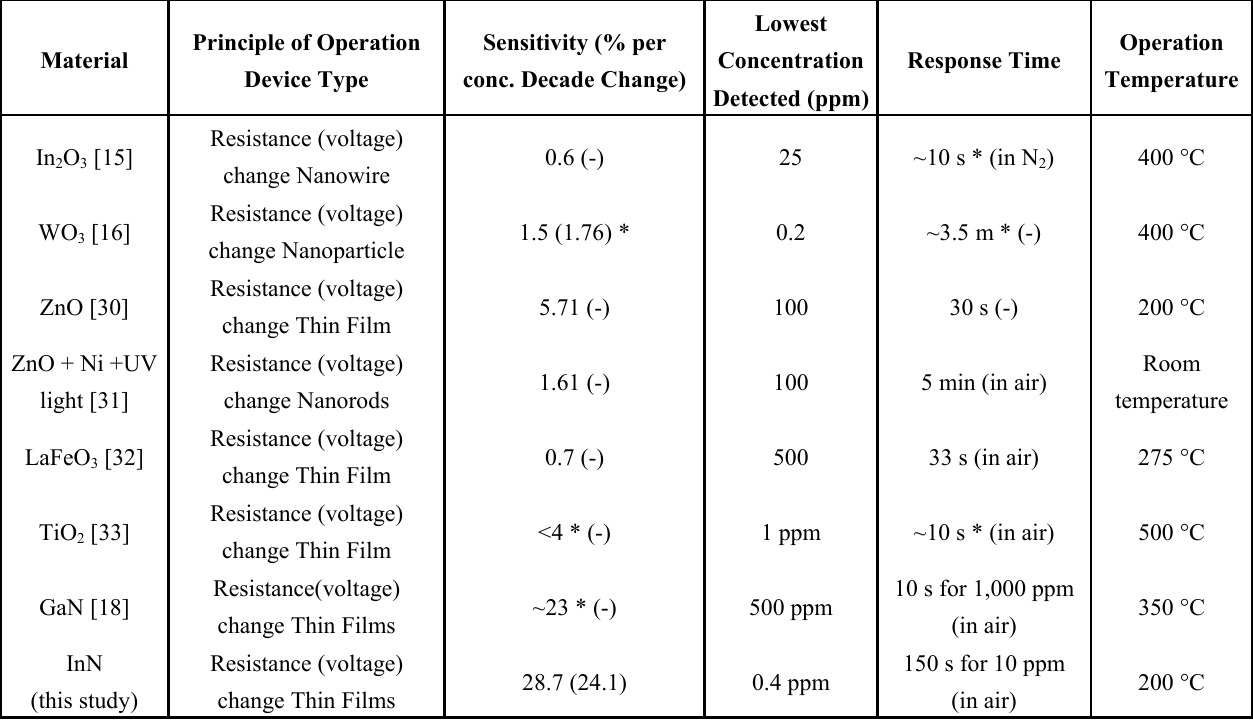
Table 1. List of acetone gas